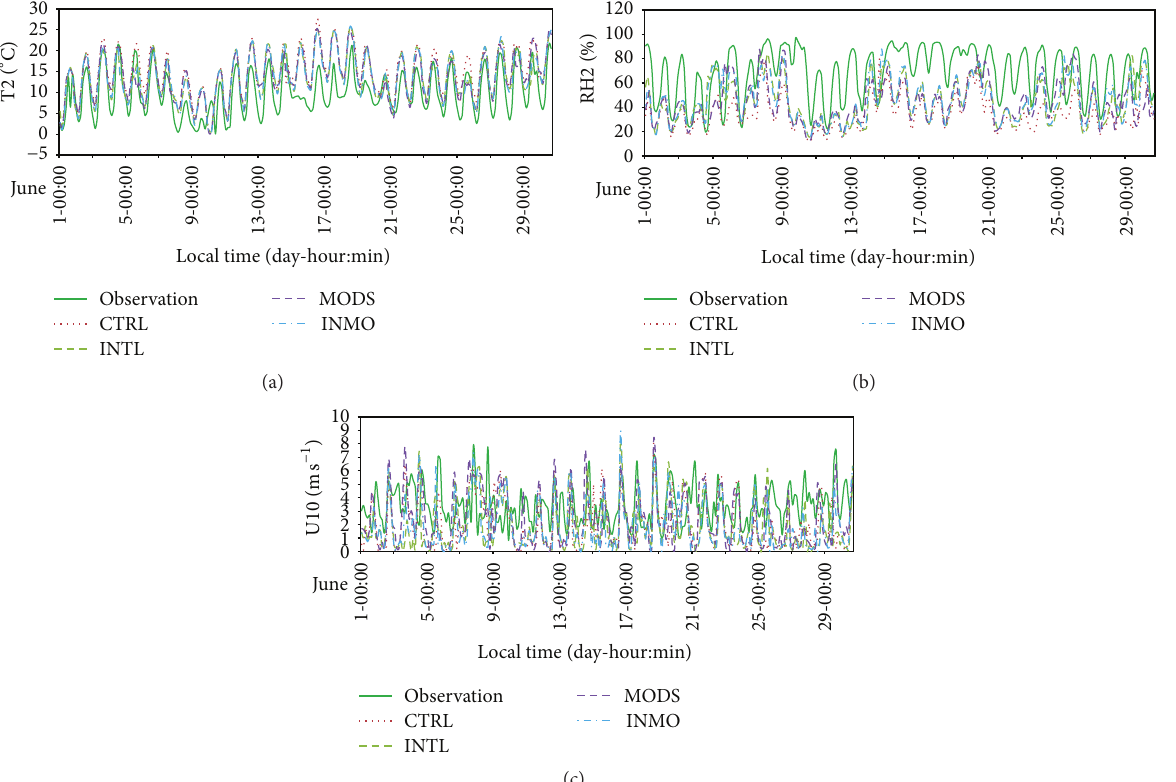
Figure 6: Modeled and observed near-surface meteorological field at Arou station: (a) 2 m temperature (T2), (b) 2 m relative humidity (RH2), and (c) 10 m wind speed